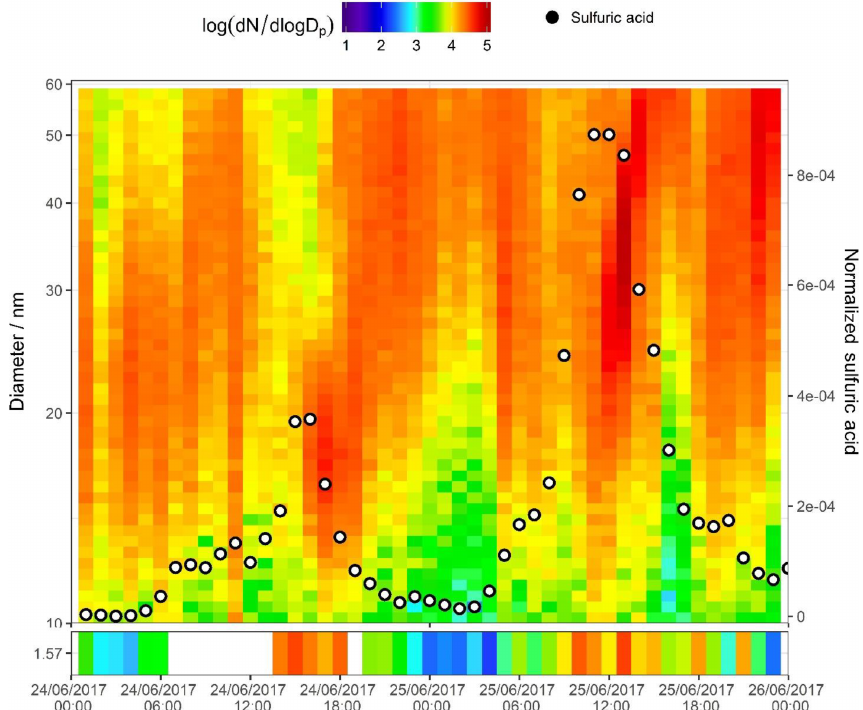
Figure 6. SMPS + PSM contour plot for two nucleation days on 24 and 25 June 2017. Data in the bottom panel are from the PSM instrument, and the top panel from the nano SMPS; units in the colour bar are log 10 (d N/ log D p ) for N in reciprocal cubic centimetres. Points signify normalized sulfuric acid concentration (right axis) as measured by